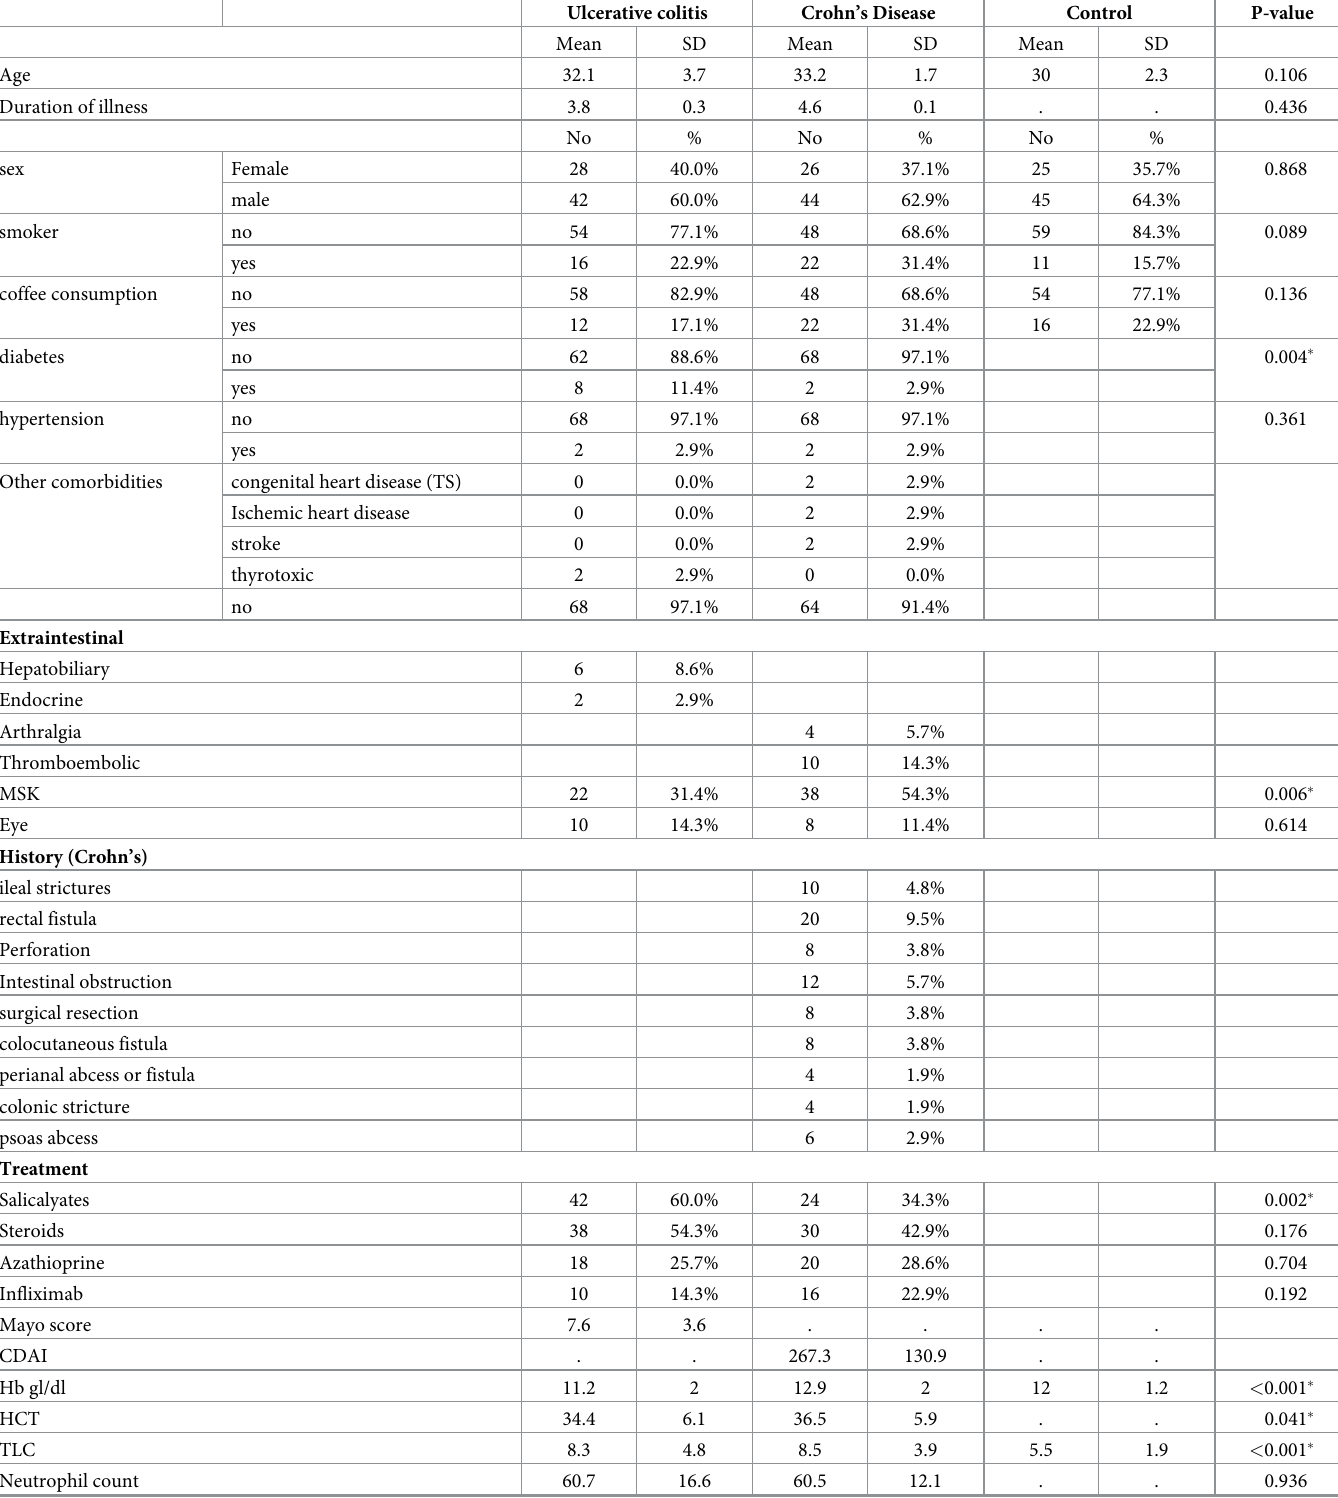
Table 1. Demographic, biochemical and clinical characteristics of the study